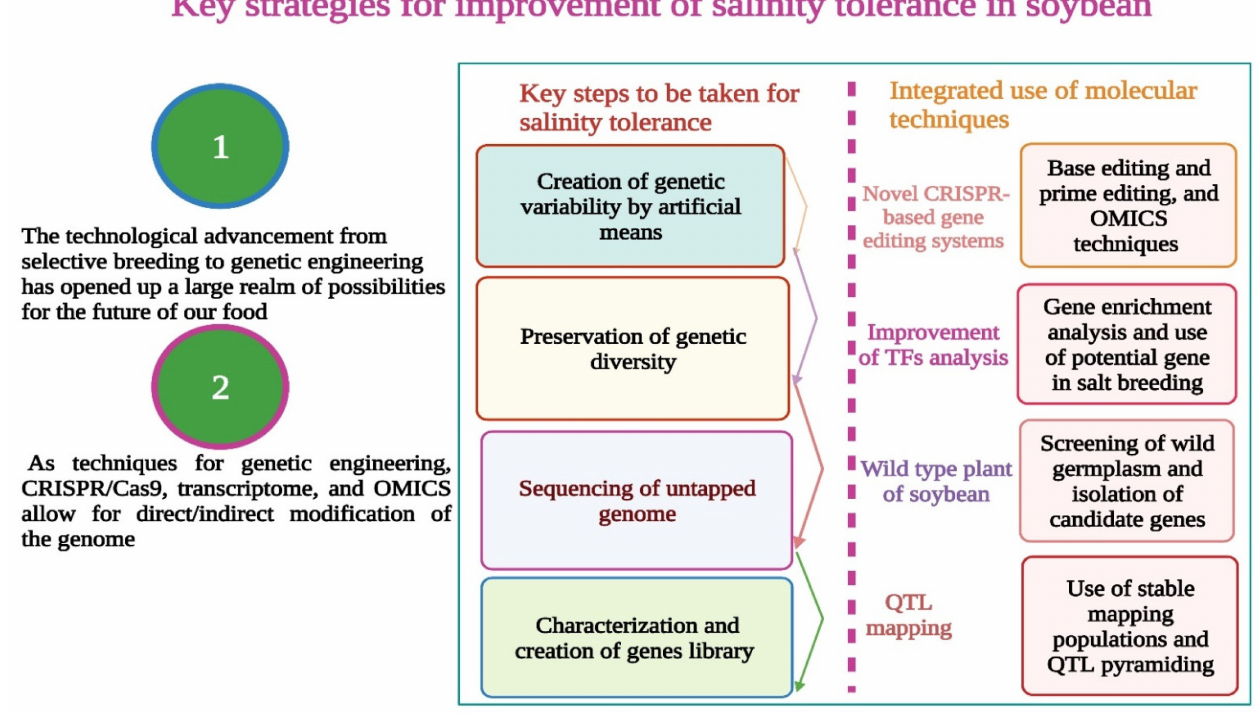
Figure 4. Salinity tolerance in soybean can be improved by using novel techniques such as, CRISPR/Cas9, genetic engineering, base editing, prime editing, genes from wild relatives of soybean, QTL pyramiding, and TF analysis. This Figure is created with